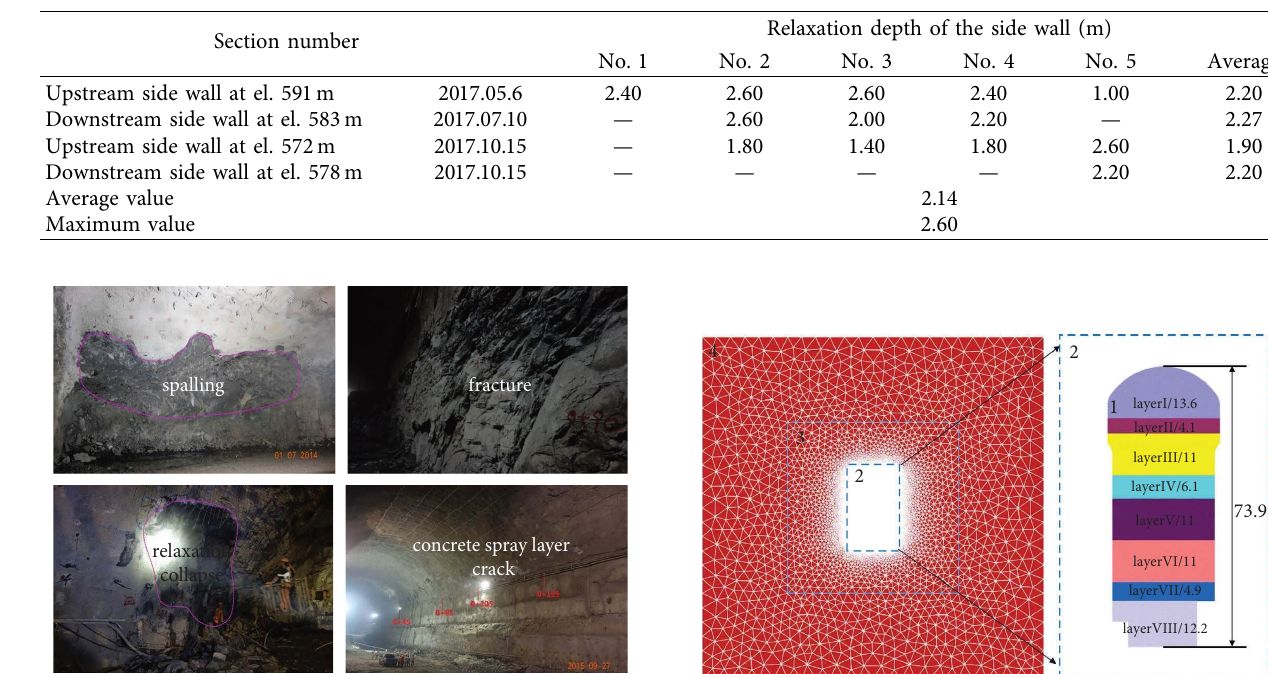
Table 3: Statistical table of acoustic test results at el. 591m, el. 583m, and el. 572m.